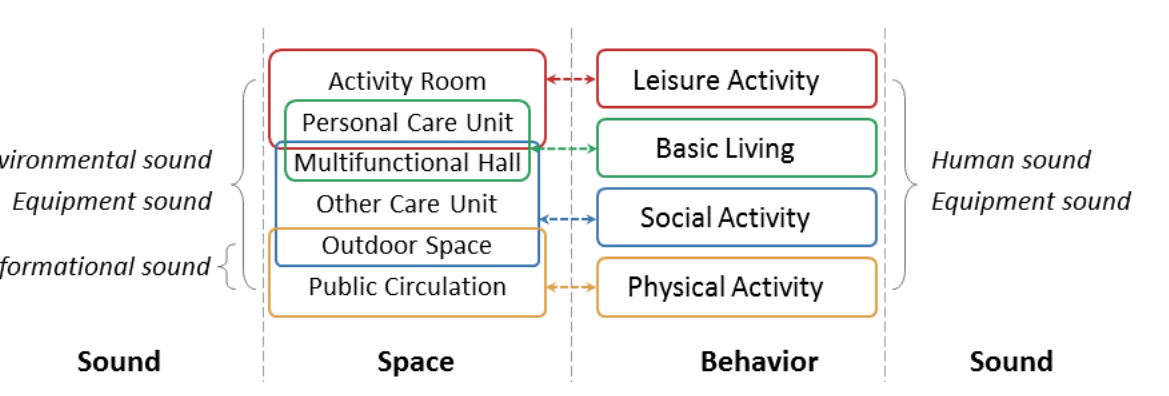
Figure 7. The relationship between behavior, sound, and space in nursing homes.